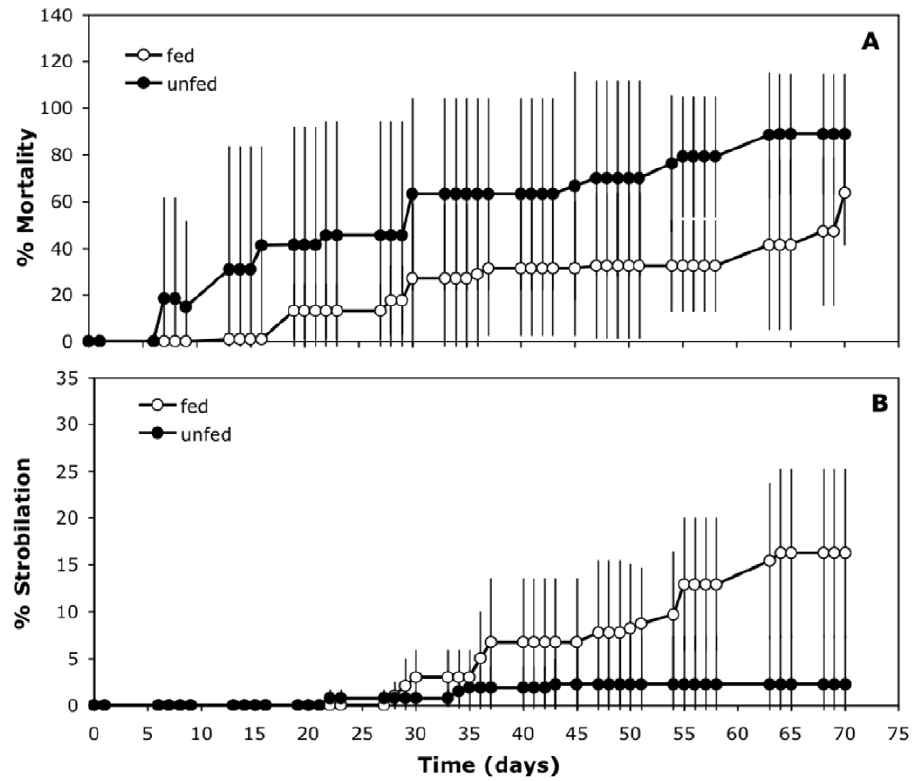
Figure 7. Effect of feeding on the percentage of strobilation during an increase in temperature (Experiment H). A ) Proportion of polyps that died without strobilating during a change of temperature from 17.5 u C to 26 u C, fed with zooplankton (empty circles) and not fed (filled circles) during 70 days. B ) Cumulative percentage of polyp strobilation in both treatments. Previously those polyps were kept at 17.5 u C for 7 months. X-axis is the time (days) after the increment of temperature. Error bars are the standard deviation of the three